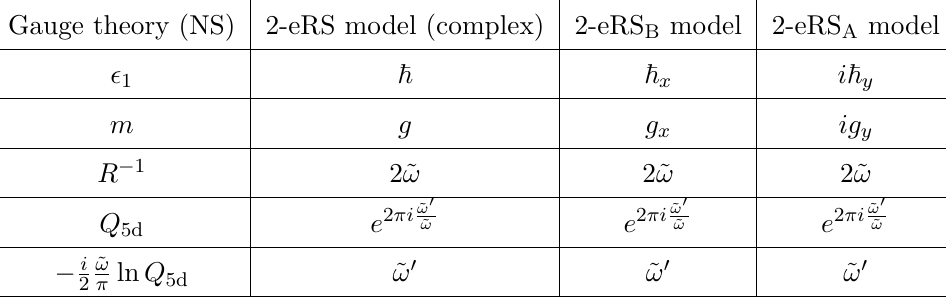
Table 6 . Map of 5d SU(2) N = 1 (cid:3) gauge theory and 2-eRS B , 2-eRS A